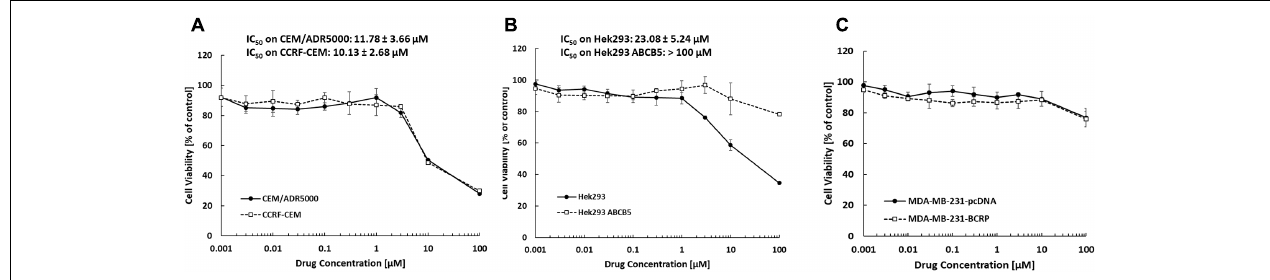
FIGURE 1 | Dose response curves of bromocriptine using the resazurin assay. Cytotoxic effect of bromocriptine against (A) CCRF-CEM and CEM/ADR5000, (B) HEK293 and HEK293 ABCB5, and (C) MDA-MB-231-pcDNA3 and MDA-MB-231-BCRP cells.